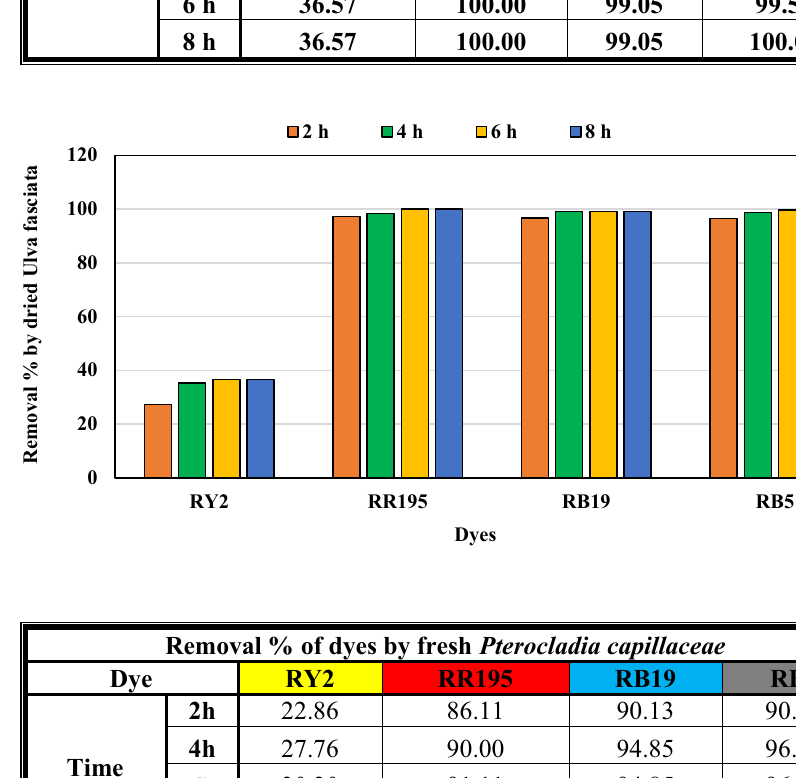
Fig. 15 Effect of contact time (at optimized conditions) on the removal percentages of the four studied dyes by fresh